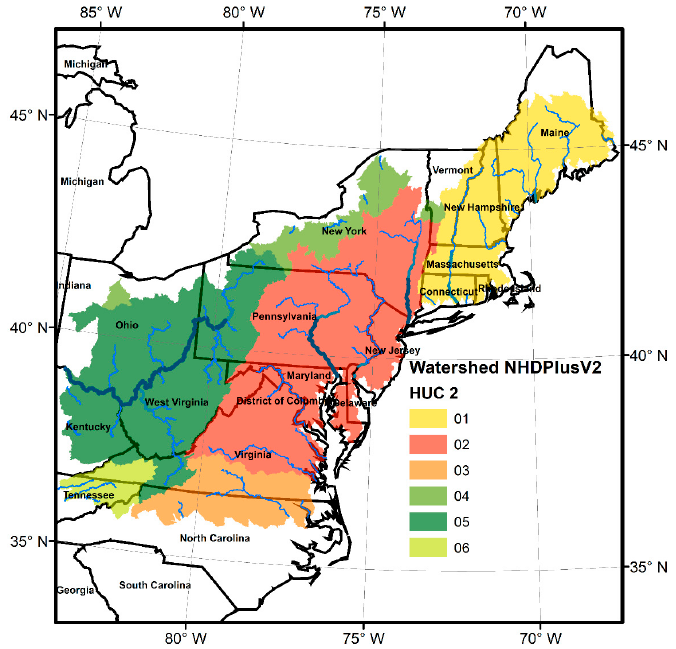
Figure 1. Model domain with routing implemented in six Hydrological Units Code level 2 (HUC-2) from the National Hydrography Dataset Plus version 2 (NHDPlusV2).